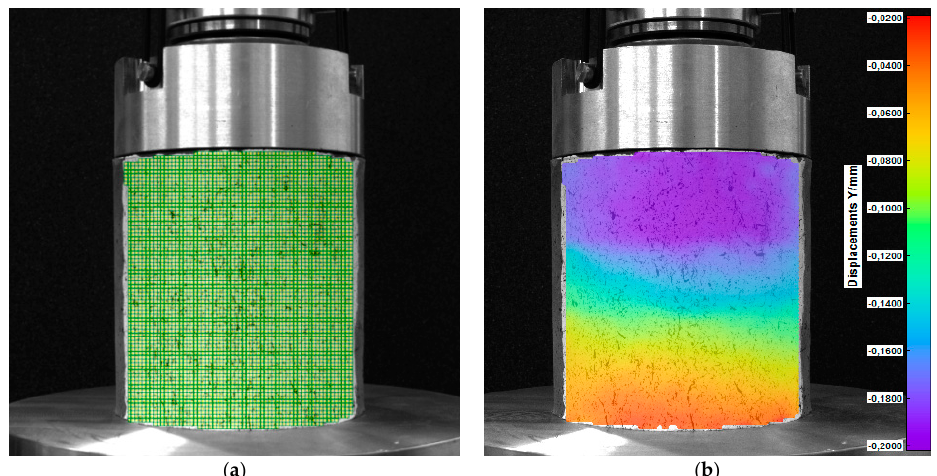
Figure 14. Soil sample under uniaxial compression: ( a ) Virtual grid of the DIC method, ( b ) vertical displacements of the sample in the compressive test [40]. Materials 2019 , 12 , x FOR PEER REVIEW